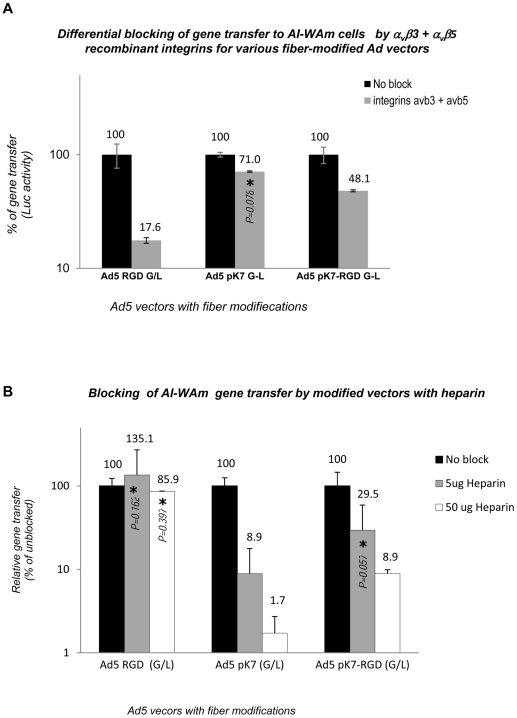
The infectivity enhancement effect of fiber-modified Ad5 vectors is mediated by αvβ3/αvβ5 integrins and/or HSPG molecules on AI-ameloblasts.
A. Differential blocking of gene transfer to AI-WAm cells by integrins. Ad5 RGD shows the highest sensitivity to integrin blocking, while transduction with Ad5-pK7/RGD (G/L) is only partially inhibited. Ad5-pK7 (G/L) gene transfer shows no statistically significant inhibition by integrins. B. Blocking of AI-WAm gene transfer by modified vectors with heparin. Heparin shows a profound dose-dependent blocking effect on transduction with pK7-modified Ads, as opposed to RGD-modified vector. Gray bars (with % values on the top) show percentage of the residual gene transfer level (RLU) resulting from blocking relative to that of unblocked controls (100%) shown by black bar for each fiber-modified vector. All bars represent mean values with standard deviations. All differences were statistically significant except where indicated by asterisk and P values (P>0.05) on the data bars.